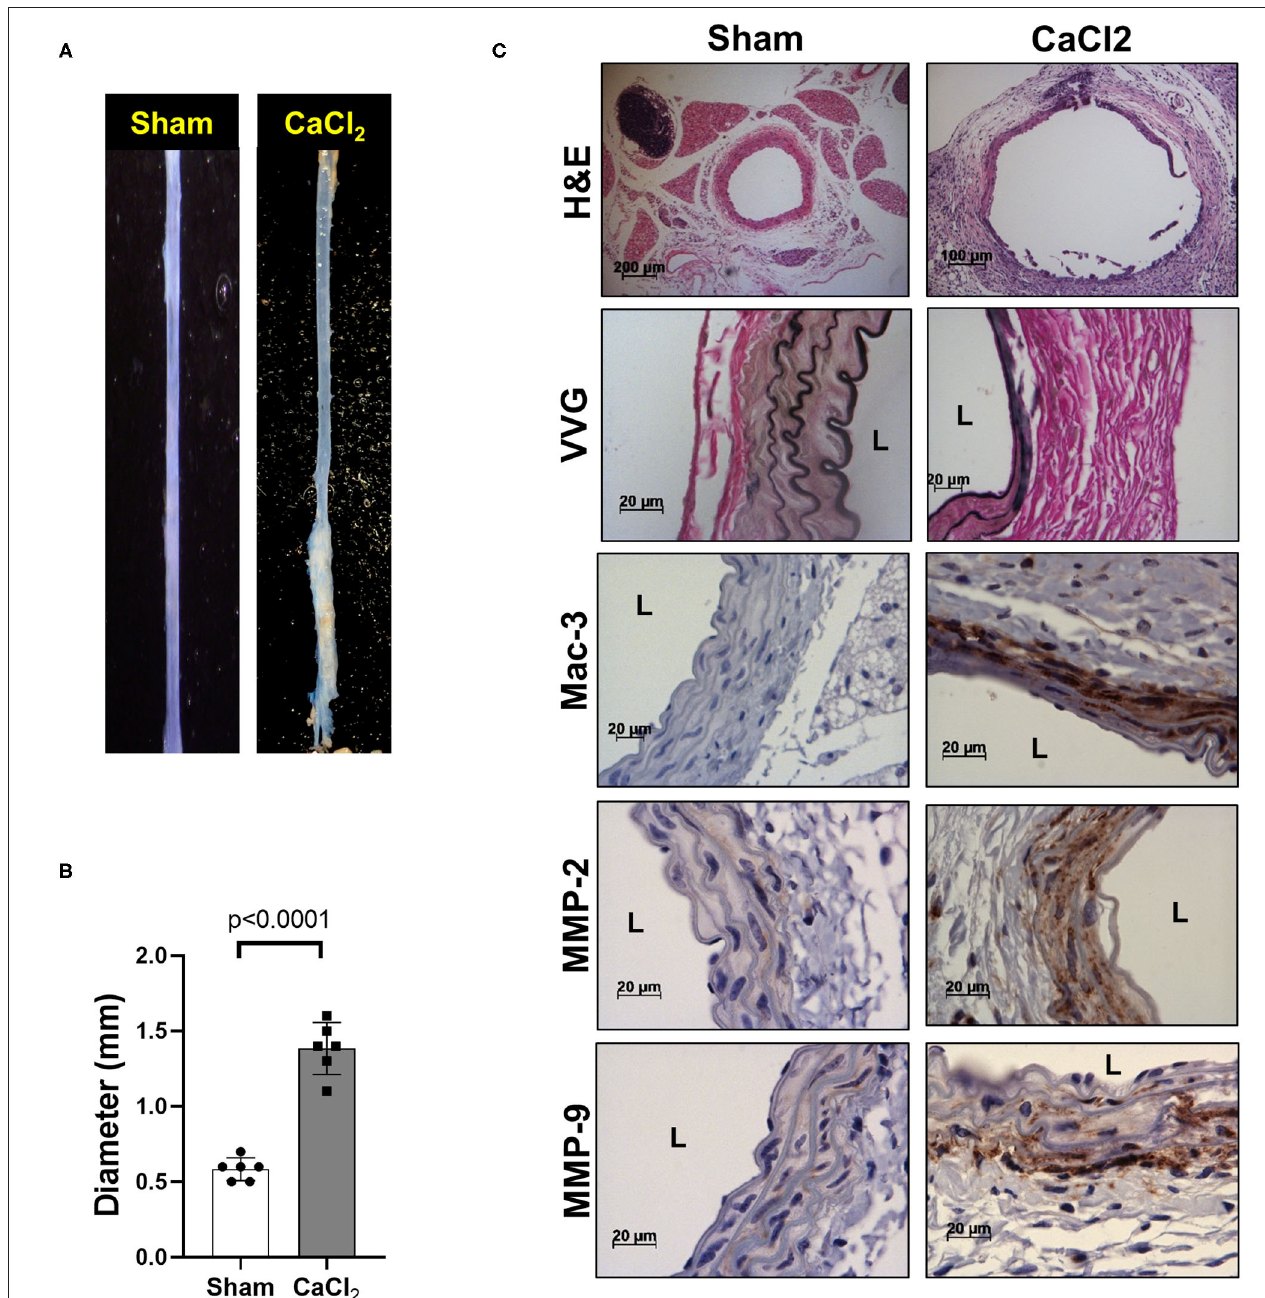
FIGURE 2 | AAA formation by periaortic CaCl 2 application. CaCl 2 was applied to the infrarenal aorta of C57Bl/6 mice, which were sacrificed at 3 weeks after CaCl 2 application. (A) Representative image of AAA formation by CaCl 2 application in infrarenal area of mouse aorta. (B) Aortic diameter. (C) Representative histology; H&E, VVG (elastin fragmentation), Mac-3 (macrophages) and MMP-2/-9, L, lumen.